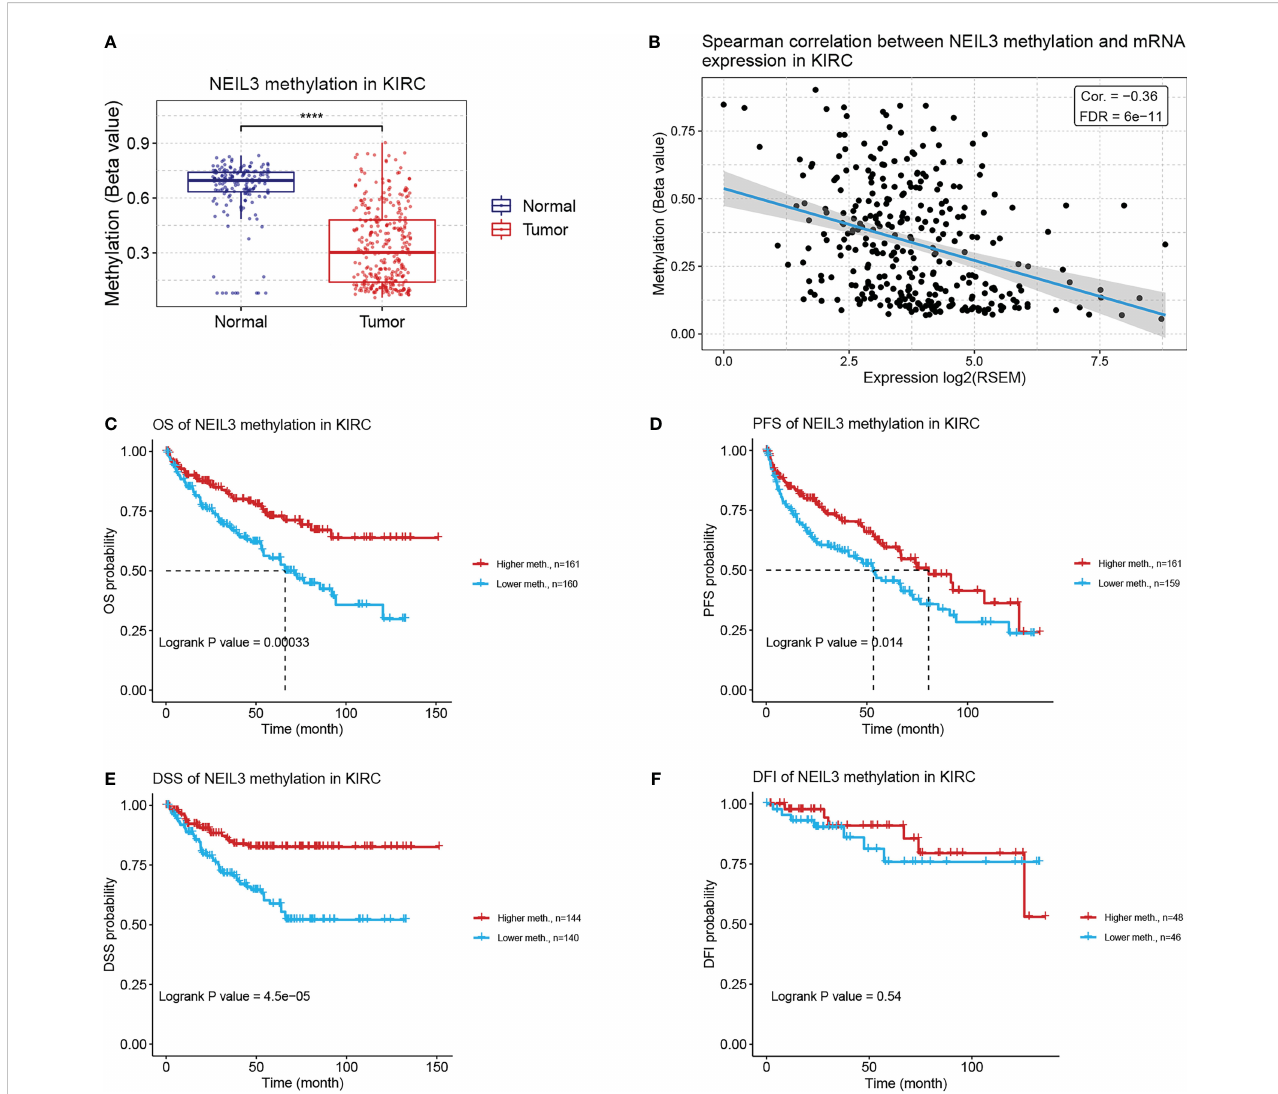
FIGURE 6 Correlation analysis between NEIL3 methylation and KIRC patients via the GSCA database. (A) The methylation level of NEIL3 between renal clear carcinoma tissues and normal renal tissues. (B) The correlation between NEIL3 methylation and mRNA expression. (C – F) The effect of NEIL3 methylation on overall survival (OS), progression-free survival (PFS), disease-speci fi c survival (DSS), and disease-free interval (DFI) of patients with KIRC. ****, P <